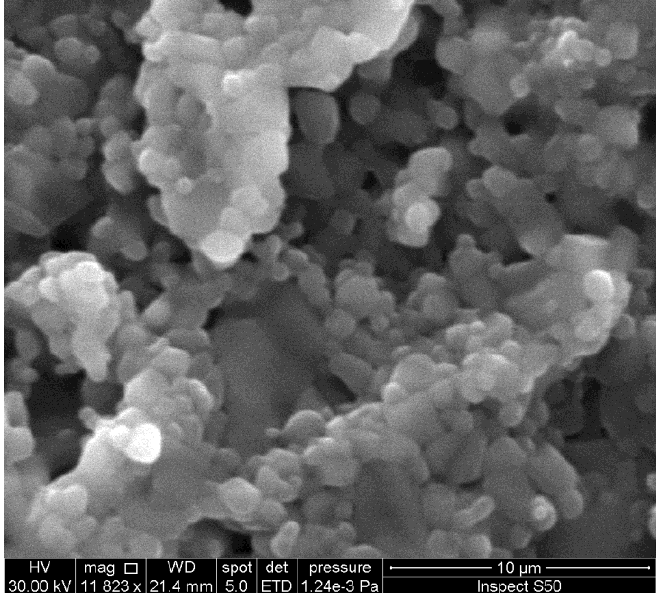
) at firing (1400 ° 2